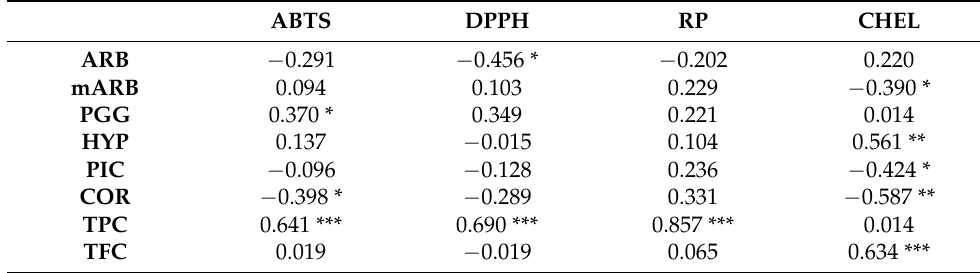
Table 5. Correlation coefficients for relationships between the studied secondary metabolites in extracts of bearberry leaves from the pine forests and antioxidant parameters ( n = 30); bolded correlation coefficients are statistically significant. Explanations see Table